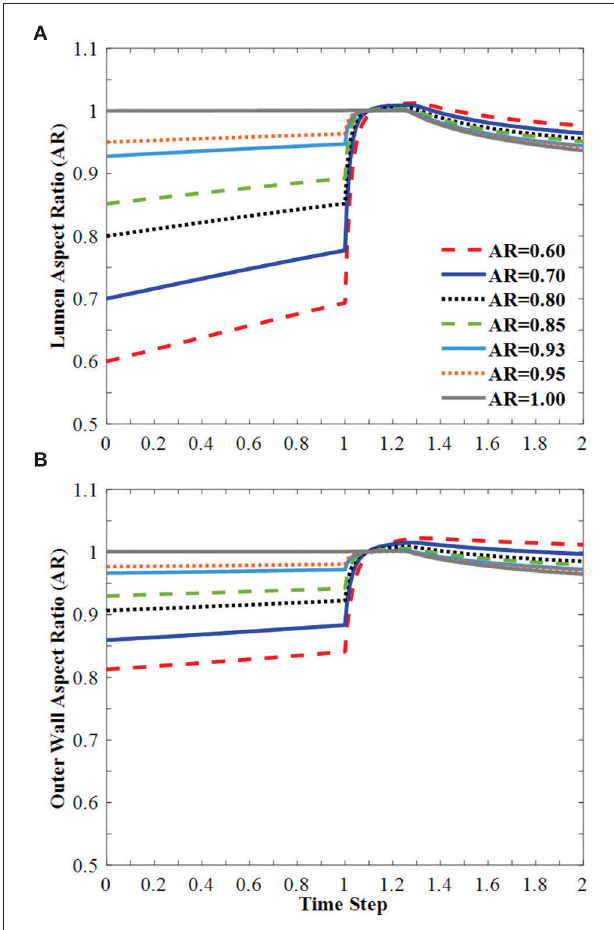
FIGURE 4 | Change of (A) lumen AR and (B) outer wall AR of the middle cross-section of the vessel under axial stretch (time steps 0–1.0 representing axial stretch ratio 1.0 to 1.3) and lumen pressure (time steps 1.0–2.0 representing lumen pressure 0–50 kPa). The vessel buckles in the direction of the minor diameter. Buckling occurred at time step